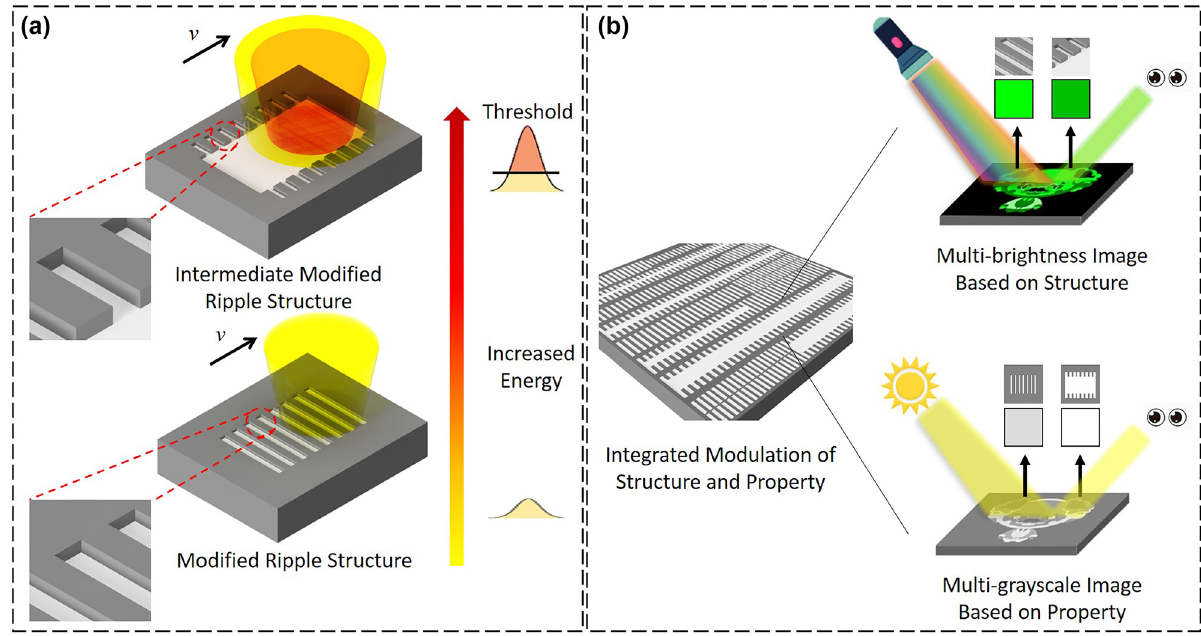
Figure 6: Schematic diagram for multifunction and multilevel rewritable optical recording. (a) Schematic of the integrated modulation of the surface structure and material properties of GST. (b) Sketch of the lighting source-dependent multifunctional and multilevel image storage based on the modified ripple structures, which is observed under illumination of strong light and natural